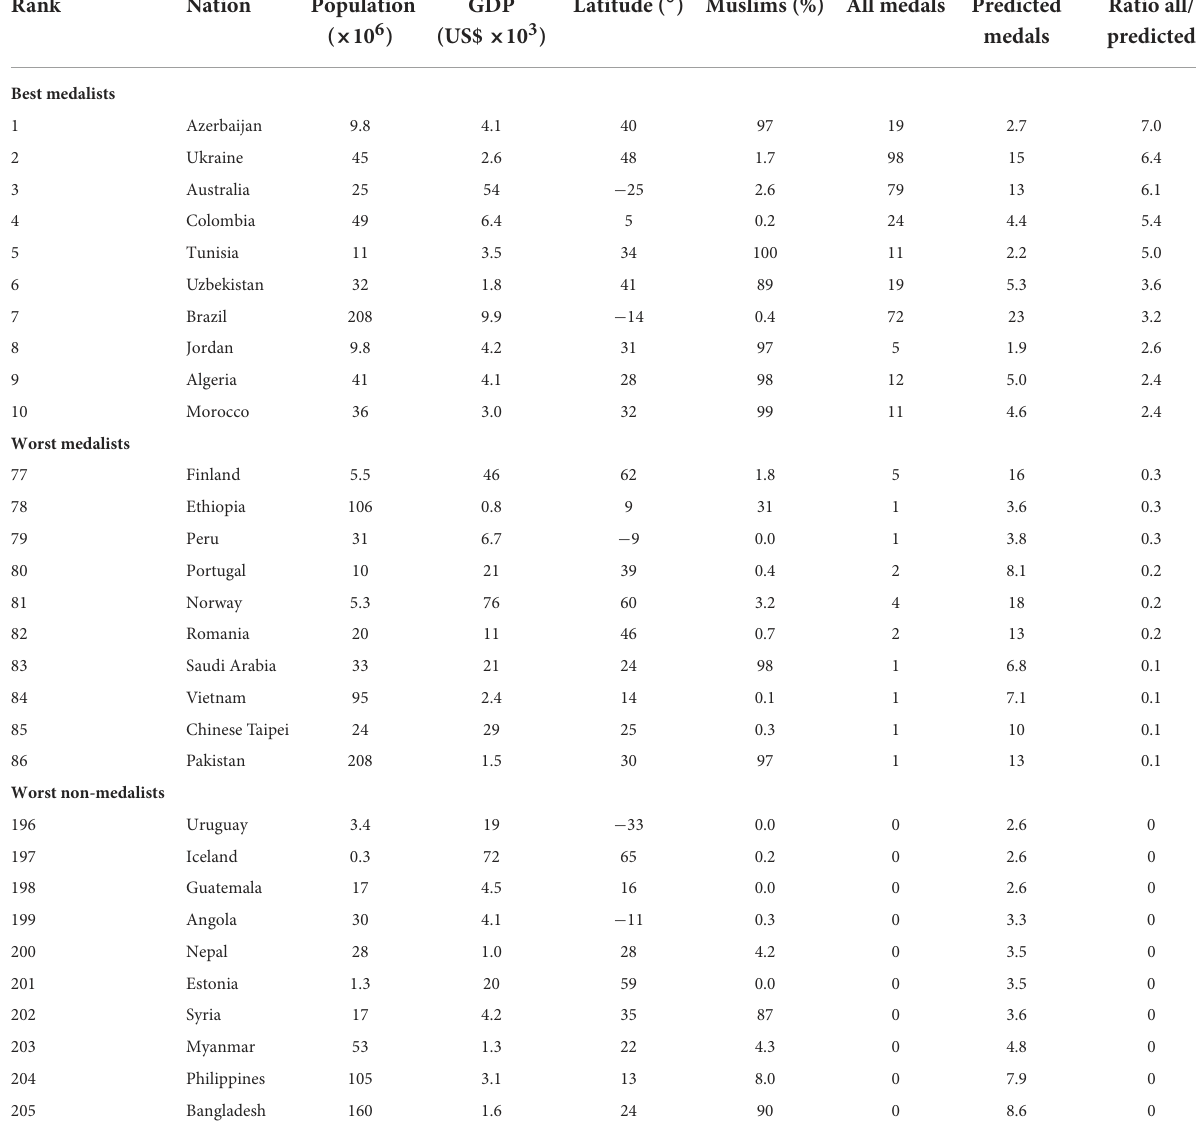
TABLE 10 Ranking of the best medalists, worst medalists and worst non-medalists at the Tokyo summer Paralympics. Rank Nation Population